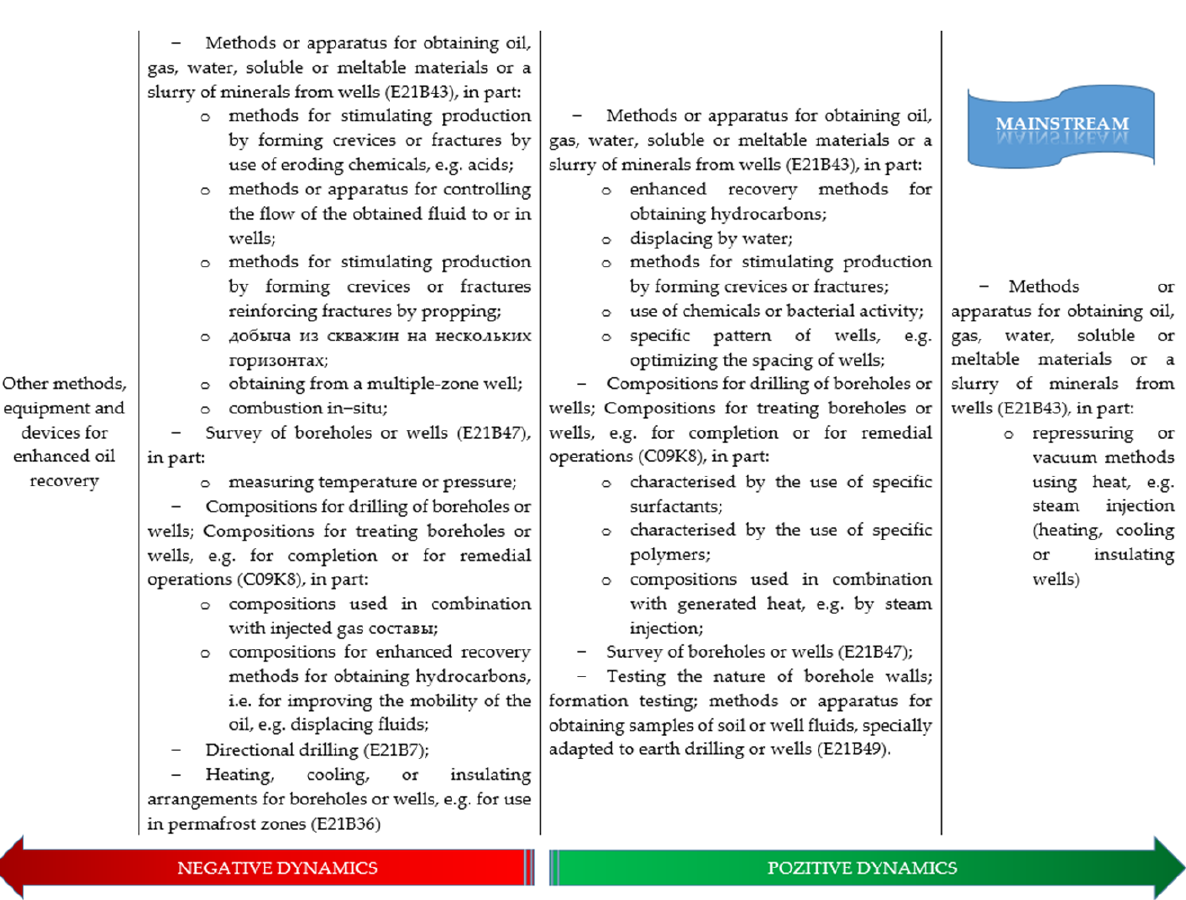
Figure 5. The mainstream technologies in the field of enhanced oil recovery methods.